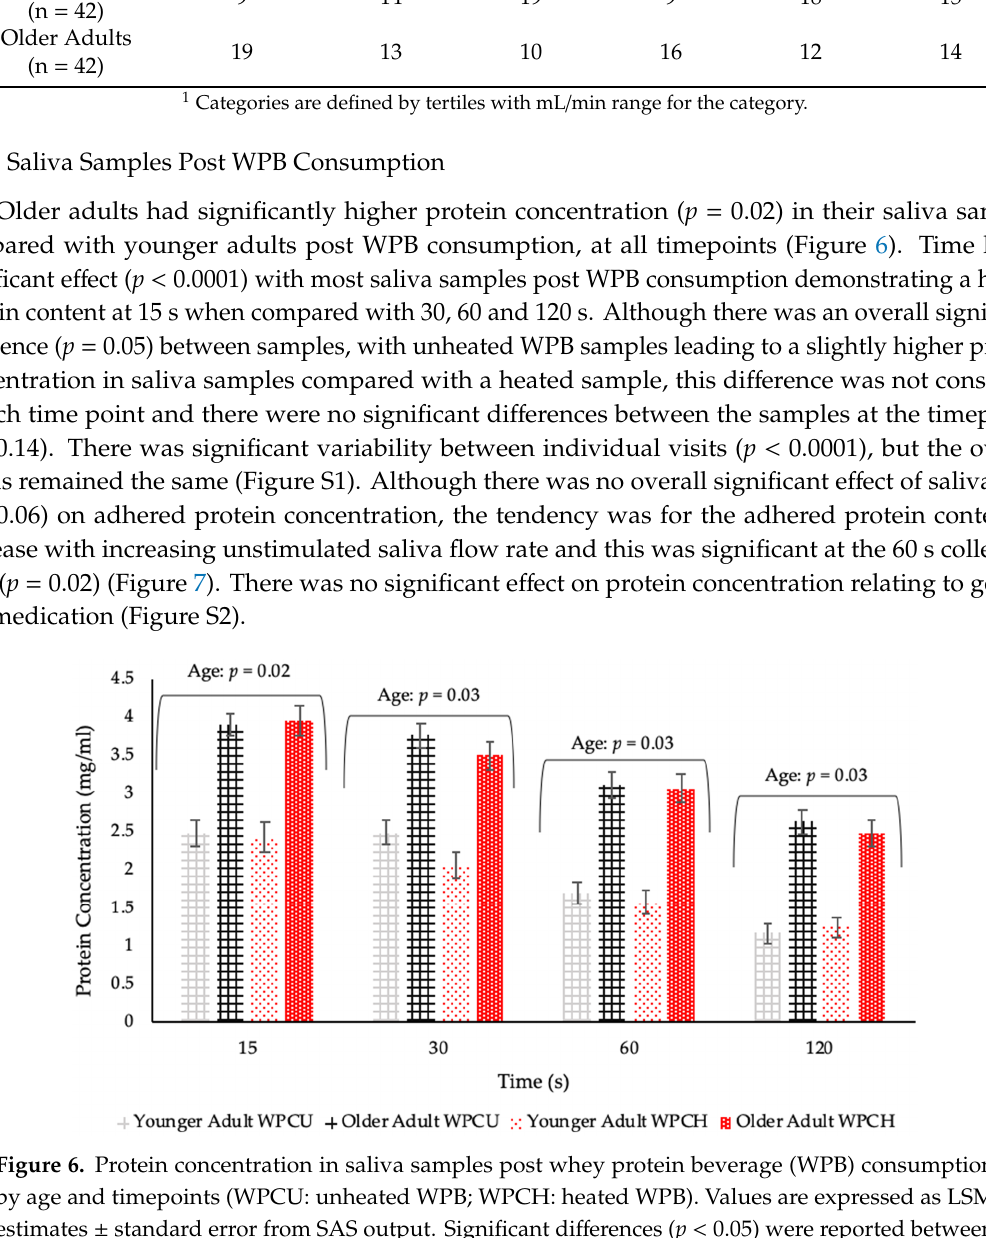
Figure 7. Protein concentration in saliva samples post whey protein beverage consumption by timepoints and saliva flow groupings. Values are expressed as LSM estimates ± standard error from SAS output. Significant differences (p < 0.05) were reported only at 60 s with relevant p value above each timepoint. Data from visit 2 (n = 84) and visit 3 (n = 82) combined. Individual saliva flow groupings are derived from unstimulated saliva flow only, through tertiary analysis.